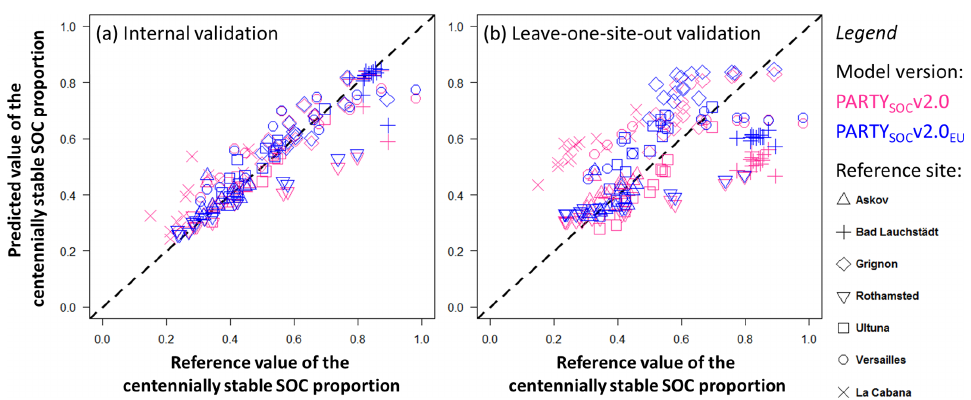
Figure 2. Performance of PARTY SOC v2.0 and PARTY SOC v2.0 EU machine-learning models based on Rock-Eval ® thermal analysis for predicting the centennially stable organic carbon proportion in topsoils. (a) Results of the internal validation procedure. (b) Results of the leave-one-site-out validation procedure (see Sect. 2.5 for more details on model performance assessment). SOC: soil organic carbon.